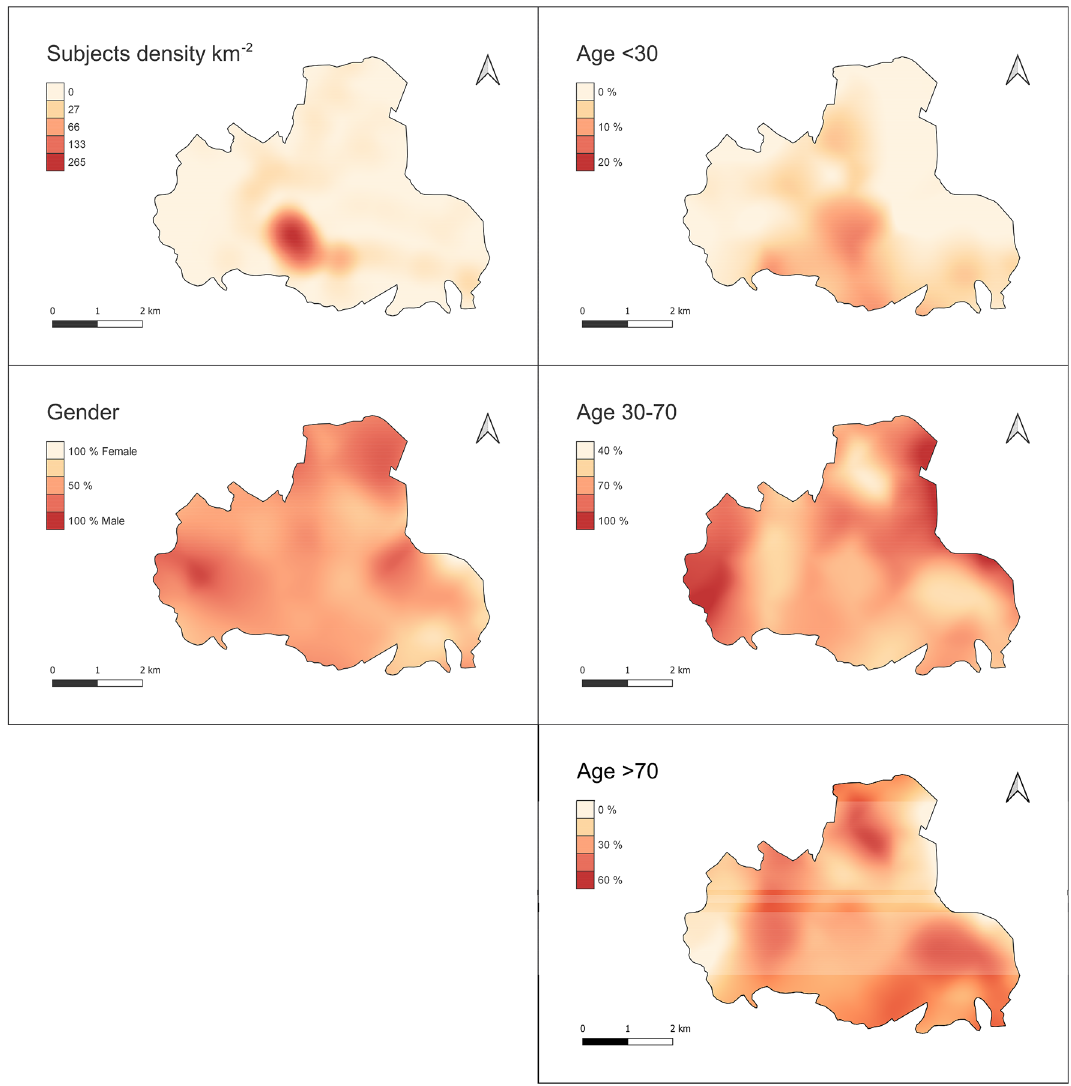
Figure 5. Maps showing the spatial density (individuals km −2 ) of all subjects in the study group and the spatial distribution of gender ratio and percentage of age groups, relative to the tested subjects, per km 2